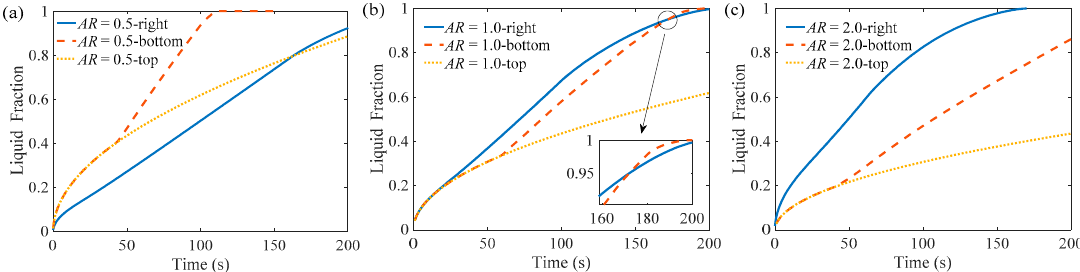
Figure 8. The evolutional liquid fraction in three enclosures by heating the different sides.